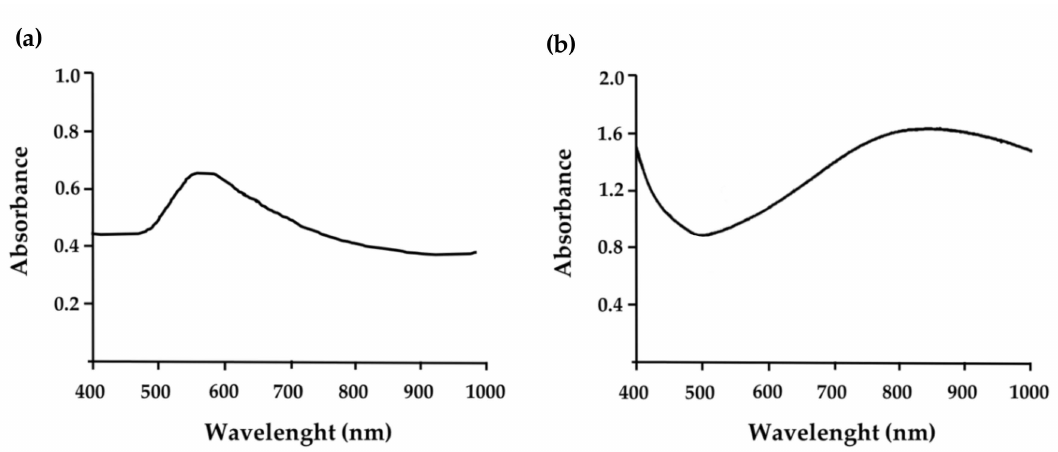
Figure 4. ( a ) Optical absorption spectrum of uncoated GNPs and ( b ) HAOA-coated GNPs, with a maximum absorption wavelength in the therapeutic optical window of biotissues (>750 nm), where absorption is lower.